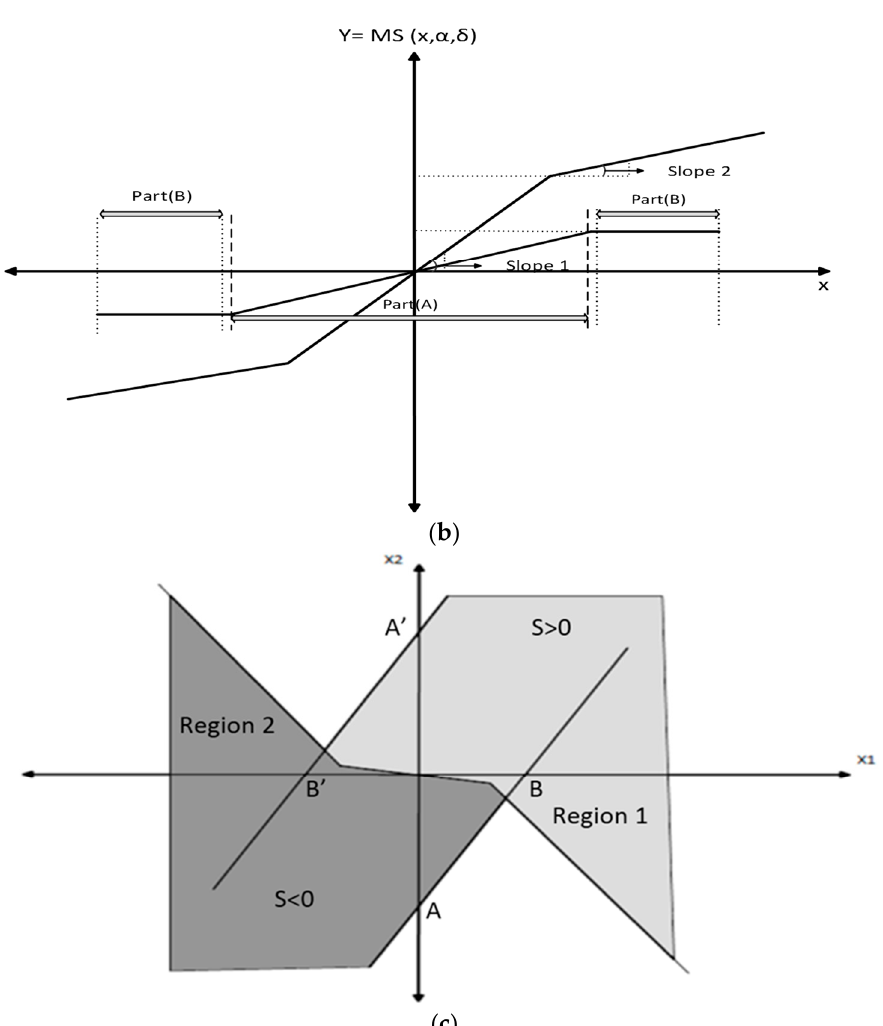
Figure 3. Suggested sliding-mode control structure: ( a ) multi-slope and linear sliding surfaces and trajectory of states during the reaching mode; ( b ) multi-slope function for different slopes of Part A and Part B; and ( c ) existence regions of sliding-mode in the x 1 -x 2 plane.